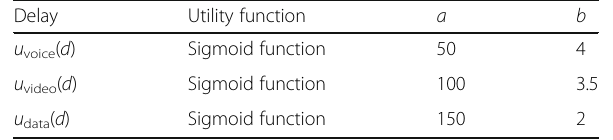
Table 2 Utility function for delay and parameter